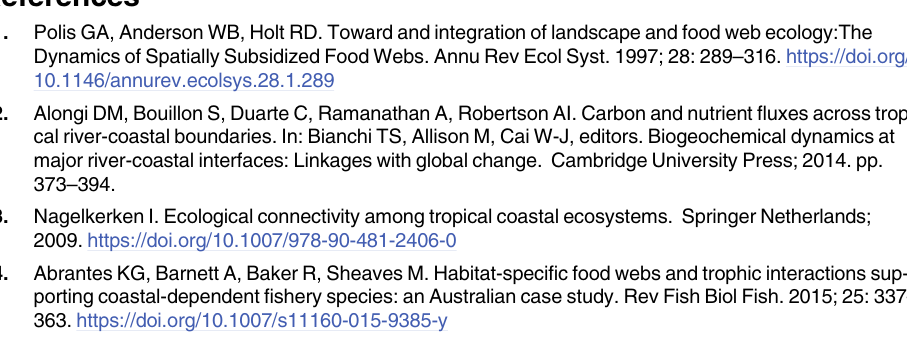
S4 Table. C:N and C:P ratios used to construct nitrogen and phosphorus networks. DE = Durban Eddy, TM = Thukela Mouth, RB = Richards Bay. S5 Table. Carbon, nitrogen and phosphorus biomasses (g m-2) of groups in each network. Bold values represent biomasses estimated by Ecopath. S6 Table. Nutrient limitations calculated from ascendency analysis, and turnover times in a node. DE: Durban Eddy, TM: Thukela Mouth, RB: Richard Bay. S: summer, w: winter. LN: Limiting Nutrient. C: carbon, N: nitrogen, P: